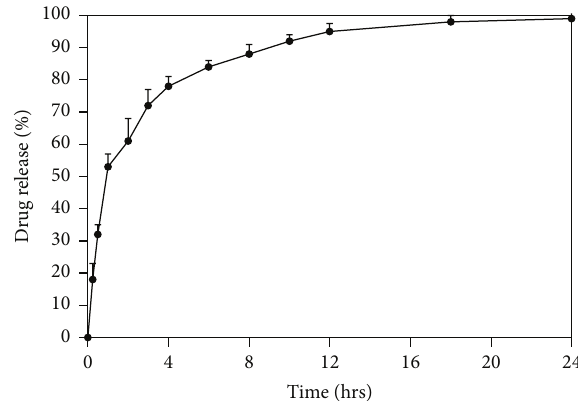
Figure 3: Plasma concentration profile of AZT solution and AZT- SLNs.